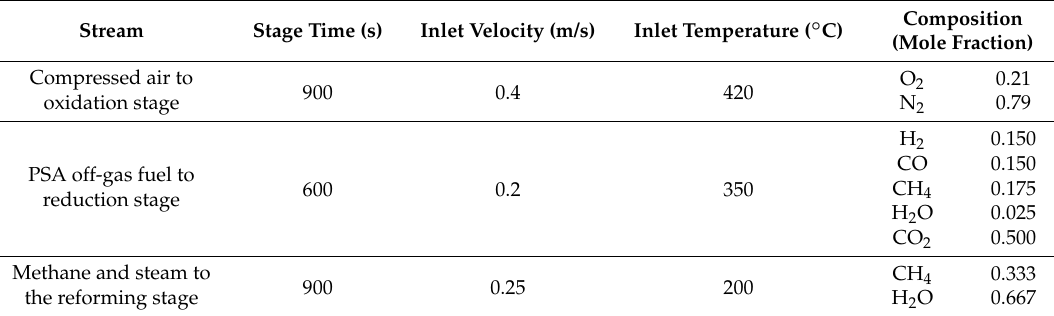
Table 2. Boundary conditions employed in the PBCLR simulation.